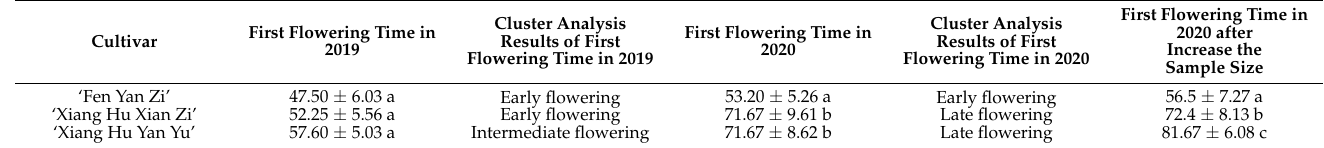
Table 3. Comparison of average number of days from planting to blooming stage of 3 Nelumbo nucifera